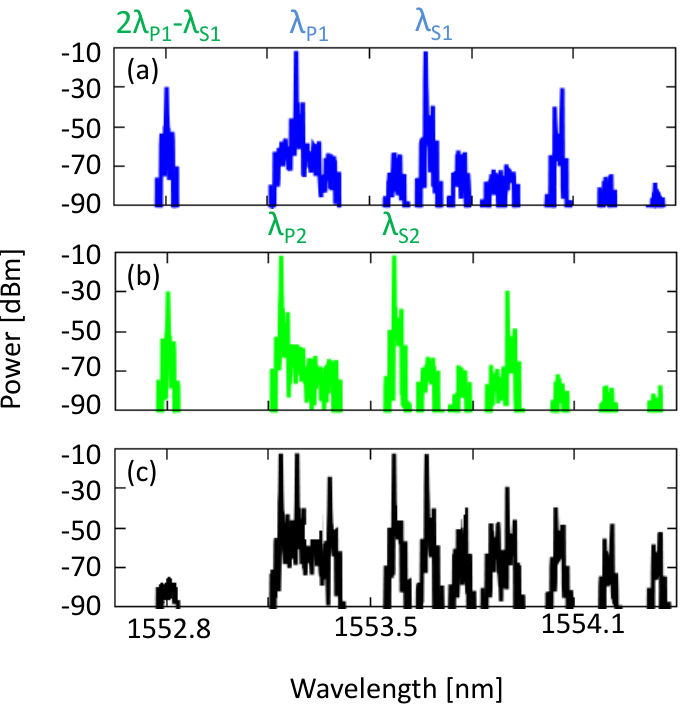
Figure 12. Simulation results illustrating the optical subtraction process. ( a ) Signal wavelength λ S1 and pump wavelength λ P1 generate an idler at 2λ P1 − λ S1 ; ( b ) λ S2 and λ P2 , which is 90  phase shifted with respect to λ P1 , generate an idler at the same wavelength as in a) but with a 180  phase shift; ( c ) λ S1 , λ S2 , λ P1 and λ P2 mix and generate two idlers at the same wavelength which are 180  out of phase, producing a